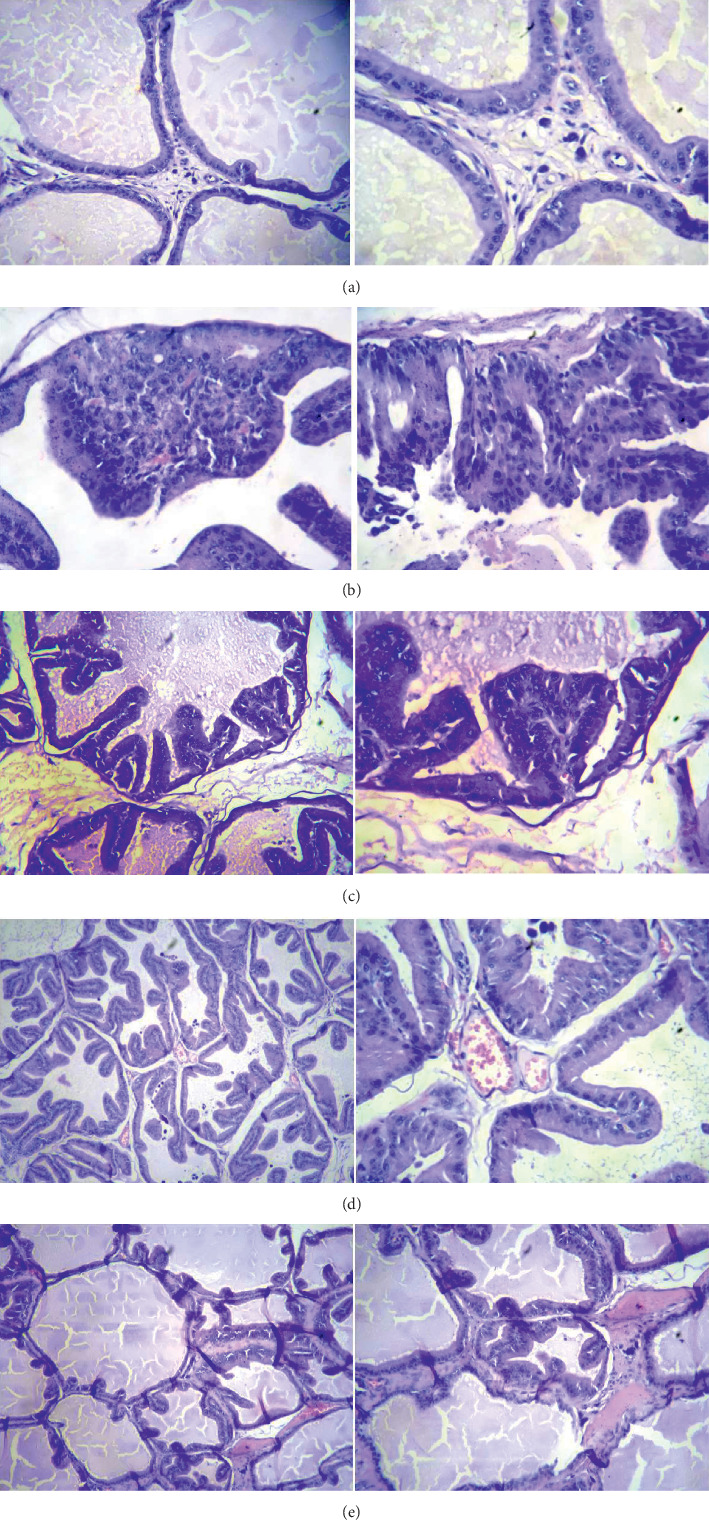
Microphotography of rat's prostate stained with Hematoxylin and Eosin (H&E), at 10 X and 40 X magnification. (a) Physiological saline 2 mL/kg. Normal. Cubic cells, not columnar. (b) Prostate tissue with induced cancer. Many layers are observed, cells in mitosis; large number of cells with high-grade prostatic intraepithelial neoplasia (HG-PIN) and low-grade prostatic intraepithelial neoplasia (LG-PIN). (c) Cordia lutea 50 mg/kg, intraepithelial neoplasia of low and somewhat grade is observed. (d) Cordia lutea 250 mg/kg, basically hyperplasia is observed, high- and low-grade foci are not reached. (e) Induced + Cordia lutea 500 mg/kg, hyperplasia is observed; it remains in hyperplasia; it does not reach high-grade or low-grade foci.